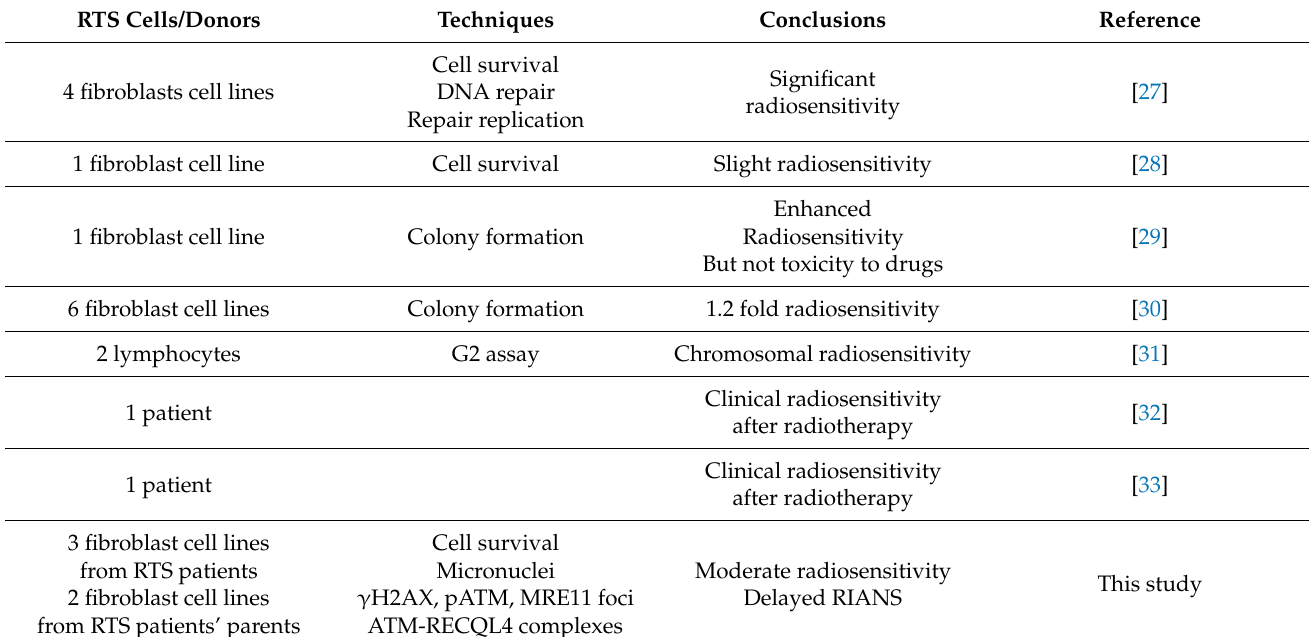
Table 2. Non-exhaustive list of studies dealing with the radiobiological characterization of RTS